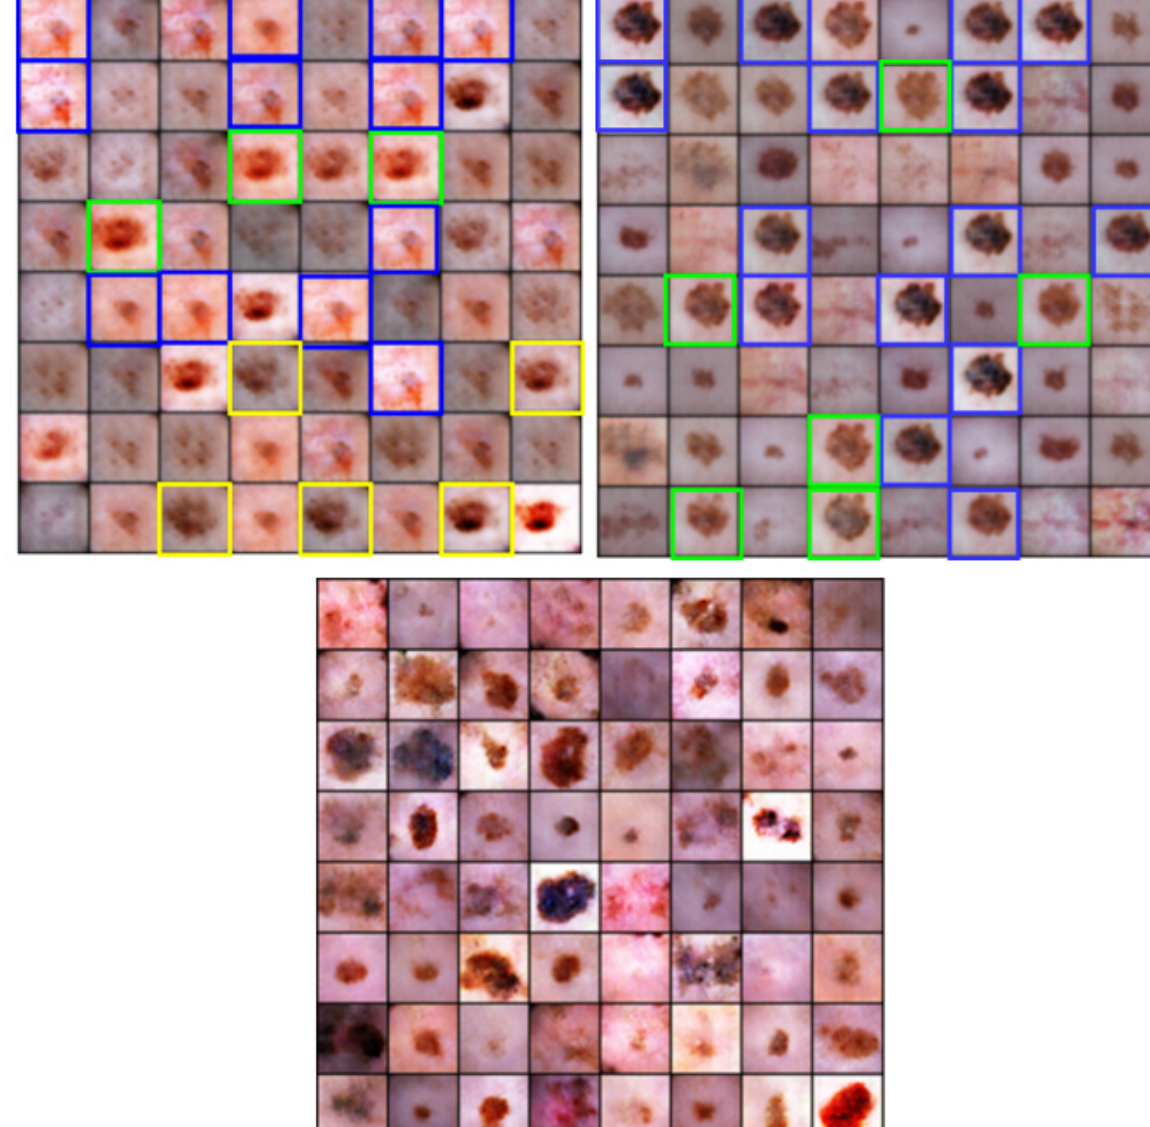
Figure 5. Artificially generated images of most swear type of skin cancer, melanoma by GANS. The top left, right, and bottom blocks of images represent the melanoma images generated by GAN, DeLiGAN, and TED-GAN (proposed), respectively. By having a close look at upper two blocks of images, we can observe the repetition of generated images. The green, blue, and yellow blocks contain similar images. Diversity in the images can clearly be observed visually in the proposed block (bottom one).